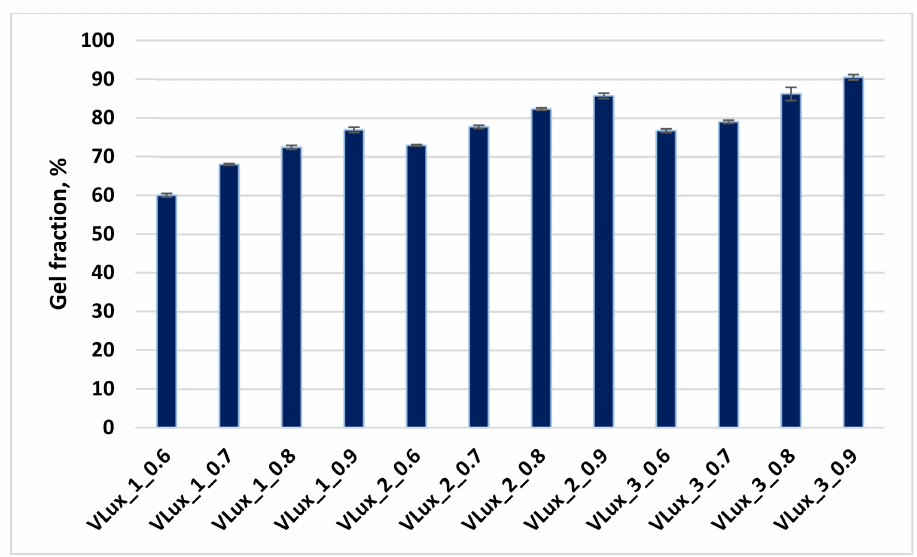
Figure 14. Gel fraction analysis of analyzed